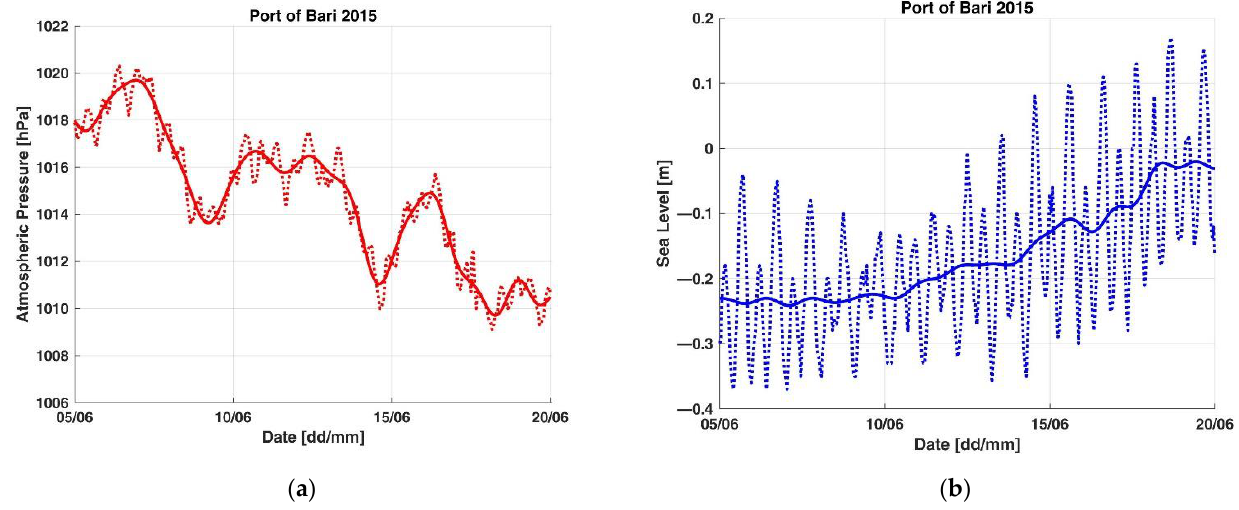
Figure A18. Low-frequency components of meteo-mareographic parameters acquired by ISPRA’s monitoring station in the port of Bari from 5 to 20 June 2015: ( a ) atmospheric pressure; ( b ) sea level.